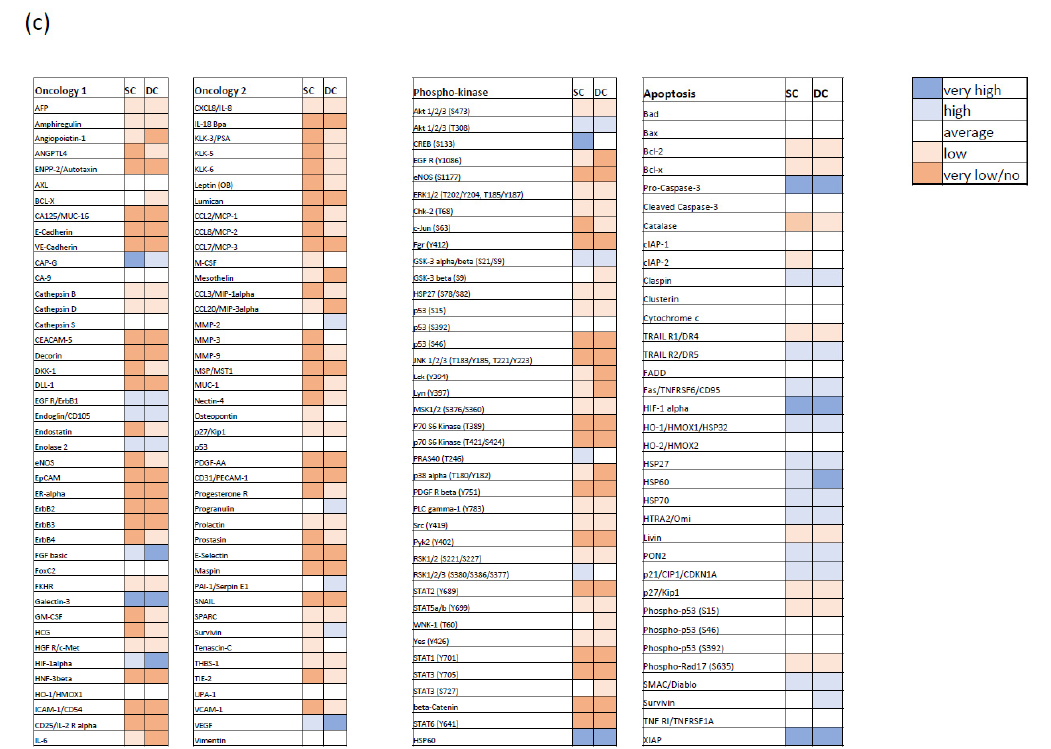
Figure 3. Characterisation of patient-derived medulloblastoma (MB) stem-like cells and short-term differentiated cells . ( a ) Schematic workflow of obtaining patient-derived MB cells. During therapeu- tically indicated surgery and following patient’s (or legal guardian’s) consent, a tumour sample sur- plus to histological characterisation and archiving was split into two. While one element was stored as reference material, the remaining tissue was further dissected and cleaned from blood cells. After several washes, fragments were sieved, and single cells/small cell clumps were cultured under non- adherent conditions in “stem cell” medium. Neurospheres that emerged after prolonged culturing were stored and characterised with reference to original tumour histology. Adherent, differentiated progeny were cultured from neurospheres via permitted adhesion and change of culture conditions, using “differentiation” medium. These differentiated populations were used for a maximum of ten generations to ensure genetic stability. Details are presented in the Materials and Methods section. Shown here are also exemplary pictures of the stem cell-like MB cells grown as free-flowing spheres and their adherently cultured differentiated progeny. Scale bar: 50 µm. ( b ) Neuropathology speci- men of the patient’s tumour stained as indicated. The H&E staining shows small, round and densely packed cells. GFAP staining is negative as for most MB tumours, while a relatively high count of Ki-67 positive areas indicates an increased amount of cycling cells. MAP2 confirms the CNS origin of the tumour, while ß-catenin indicates that the tumour exhibits SHH activity. In addition, Alcian and PAS was used to detect polysaccharides, elevated in cancers. Taken together, these data suggest a medulloblastoma belonging to the SHH